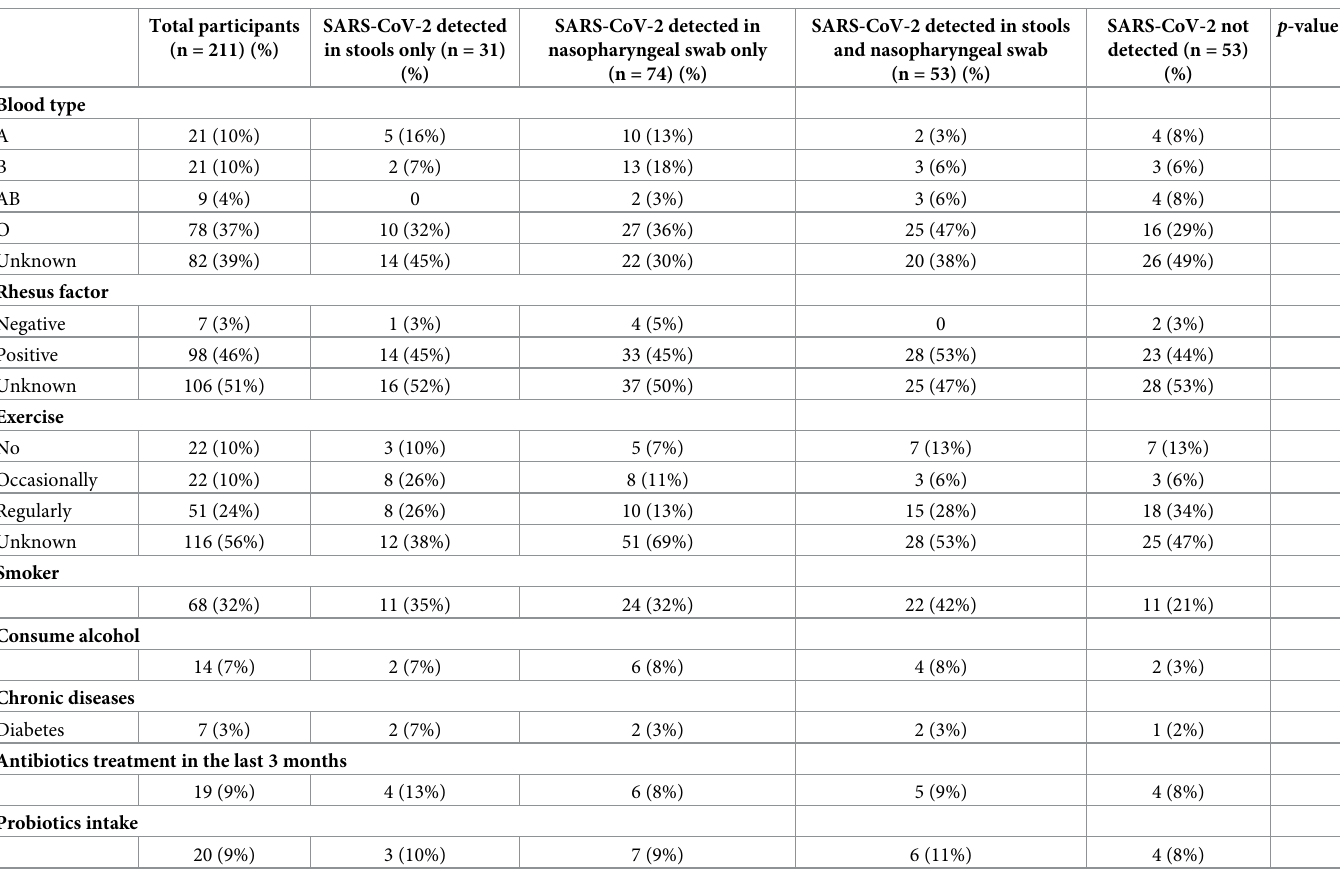
3.2. SARS-CoV-2 viral loads in stools and nasopharyngeal swabs Quantitative RT-PCR was performed to quantify SARS-CoV-2 viral RNA copies in stools and nasopharyngeal swab samples. The quantified viral loads in the nasopharyngeal swabs of par- ticipants that tested positive for the virus in both samples were significantly higher than that detected in stool samples ( p < 0.001) (Fig 3A). The viral loads ranged from 1.63 and 4.45 × 10 6 copies/mL, with a median of 1.01 × 10 3 copies/mL in stools and between 15 to 1.78 × 10 8 copies/ mL, with a median of 4.79 × 10 3 copies/mL in nasopharyngeal swabs. Regression analysis showed no correlation between the viral loads measured in stool and nasopharyngeal samples in a given patient R 2 = 0.01, F (1, 52) = 1.92, p = 0.17 (Fig 3B). An additional analysis comparing the viral load in stools and nasopharyngeal swabs between the four most identified S protein mutations in the studied group ( � 10 cases) was performed. The quantified viral load was significantly higher in the nasopharyngeal swabs compared to stools for N501Y mutation ( p < 0.001), and N501Y+K417N+E484K mutations ( p = 0.02) (Fig